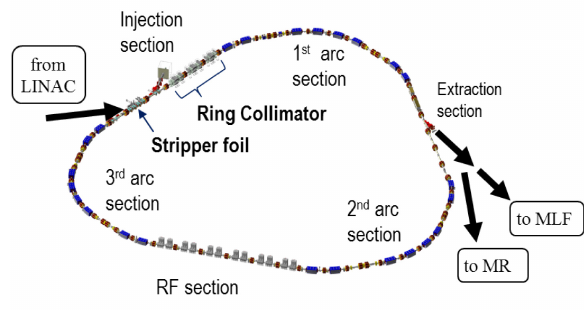
Fig. 1. Schematic view of J-PARC RCS ring.